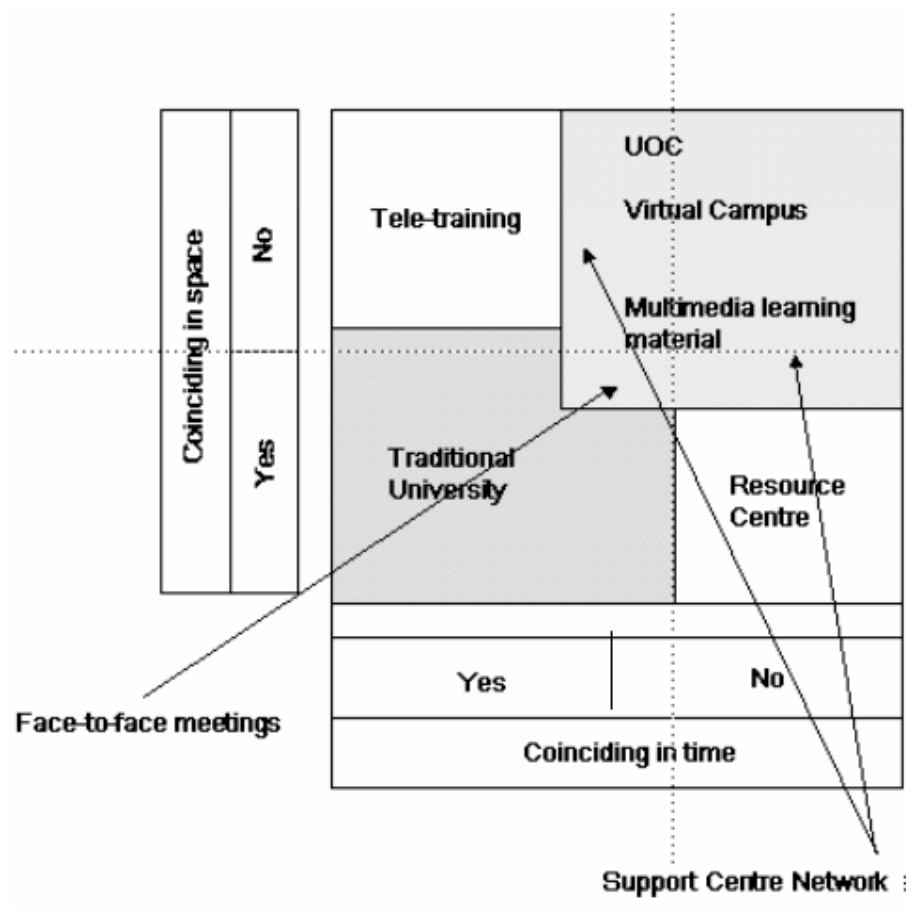
Figure 1. Educational Coincidence in Space and Time (Duart and Sangra, 2000, p.